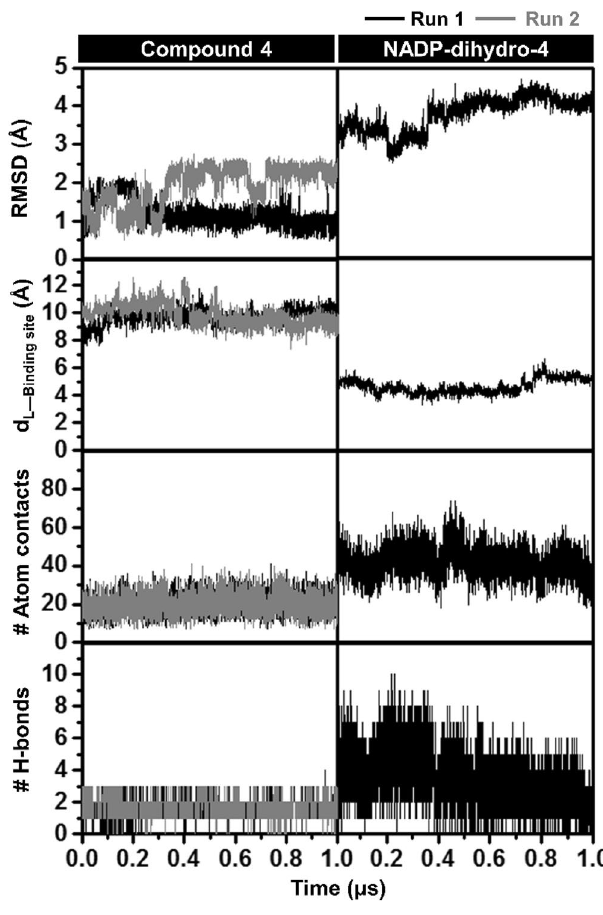
dihydro- 4 and binding residues (d L-Binding site ), # Atom contacts and #H-bonds of compound 4 (Runs 1 and 2) and NADP-dihydro- 4 (Run 1) in complex with SRD5A1 along with the 1-μs MD simulations. The angle